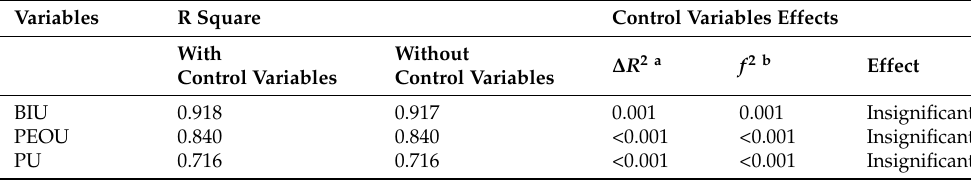
Table 4. Multivariate coefficient of determination ( R 2 ) results.